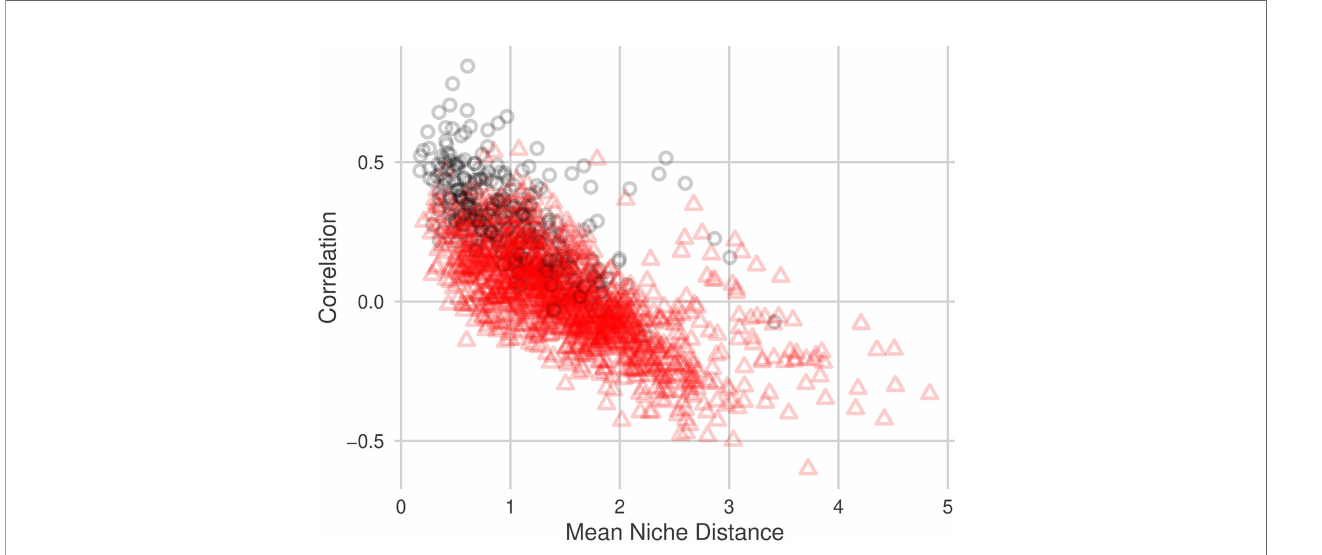
FIGURE 4 | Relationship between pairwise mean niche distance and pairwise NPN correlation estimate, ^ S . Black circles indicate that the taxa pair are within the same sub-community, red triangles indicate that the taxa pair are in different sub-communities. Niche distances were calculated using all 10 environmental variables described in Section 2.1.2.